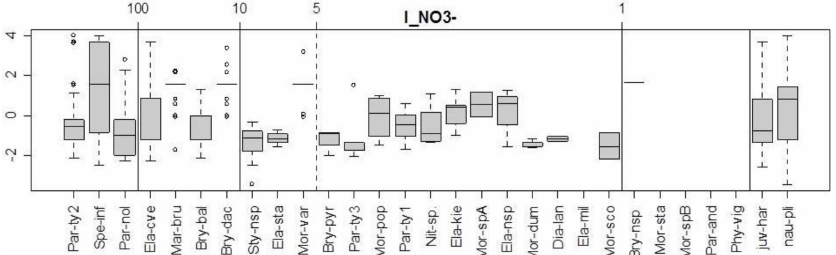
Figure 6. Box and whiskers plot of the log NO 3 − concentrations (mg / L) for di ff erent copepod species, which are arranged by their abundance (indicated by the vertical lines). The rectangles enclose the middle 50% of the data, the line across each rectangle is the group median, the “whiskers” are the minimum and maximum values. Species names are Par-ty2: Parastenocaris sp.2; Spe-inf: Speocyclopes infernus; Par-nol: Parastenocaris nolli alpine; Ela-cve: Elaphoidella cvetkae; Mar-bru: Maraenobiotus